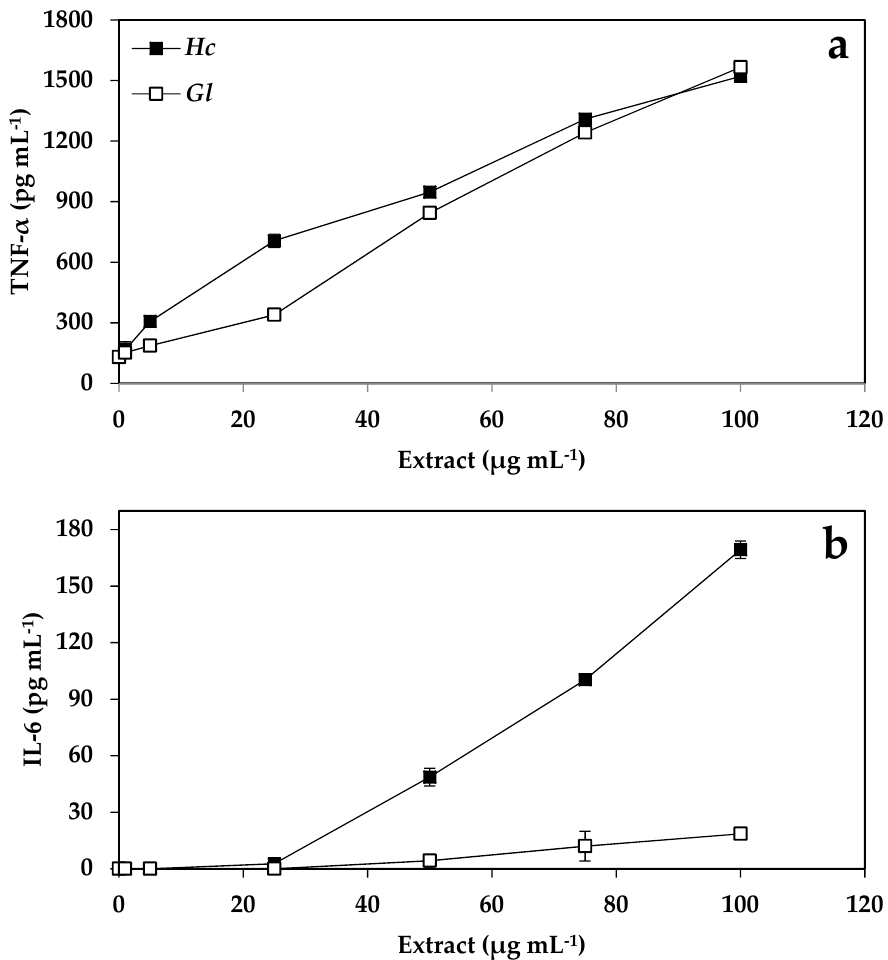
Figure 2. Concentration of tumor necrosis factor (TNF- α ) synthesized by RAW macrophages (pg mL − 1 ) ( a ) and production of interleukin-6 (IL-6 pg mL − 1 ) by RAW macrophages ( b ) exposed to different concentrations of extracts of H. cornea and G. longissima . Data are expressed as the mean of three samples ± SE.